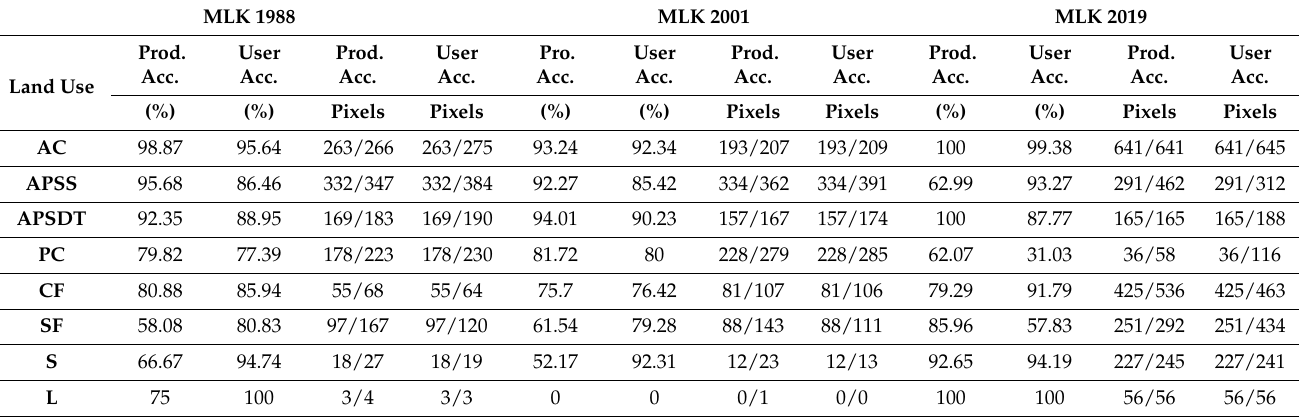
Figure 6. NSI ( a – c ), NDSAI ( d – f ), and MLK ( g – i ); blank areas represent the settlements which were excluded from the analysis. Table 6. User’s and producer’s accuracy by classes.